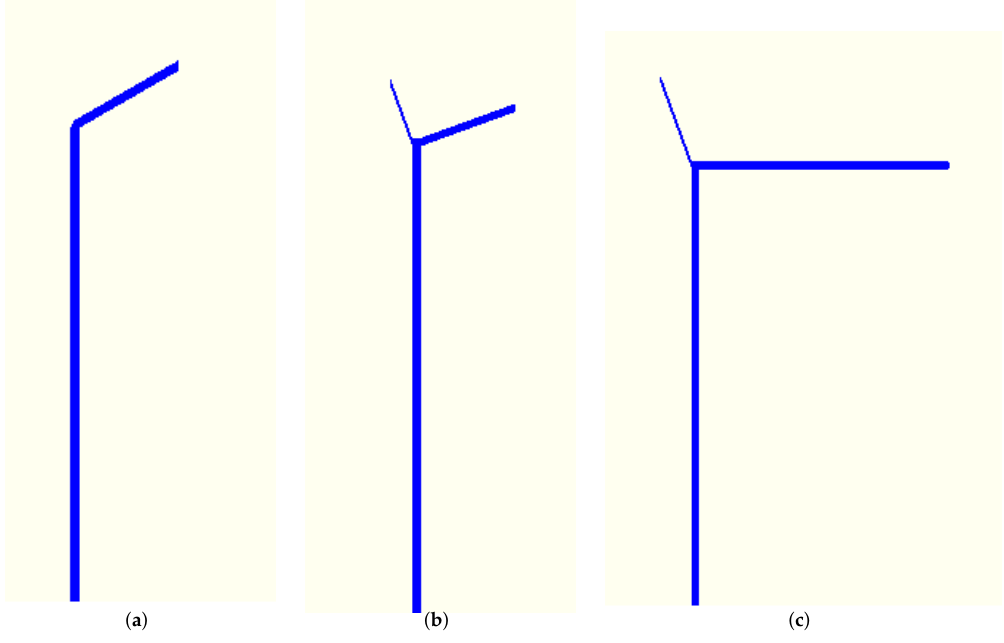
Figure 7. Representative cross-sections of the types of mitigation barriers studied: ( a ) Single-fairing barrier. ( b ) Compound-fairing barrier. ( c ) Barrier with deep